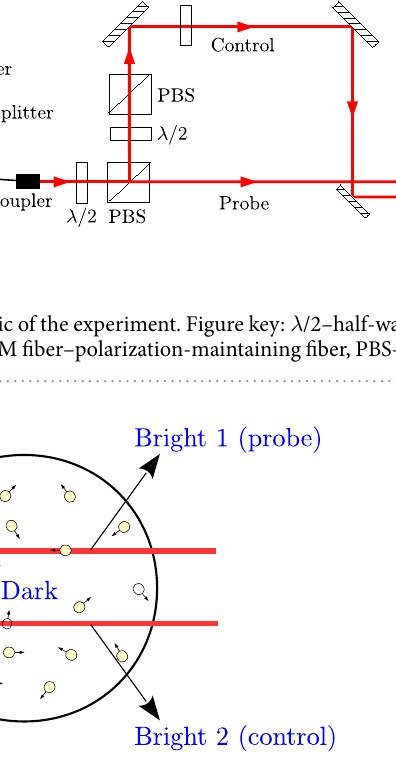
Figure 2. Spatially separated probe and control beams used in the experiment. The regions are labeled Bright 1, Dark, and Bright 2. Atomic coherences are transported by thermal motion in the vapor cell, which survives only if there is paraffin coating on the